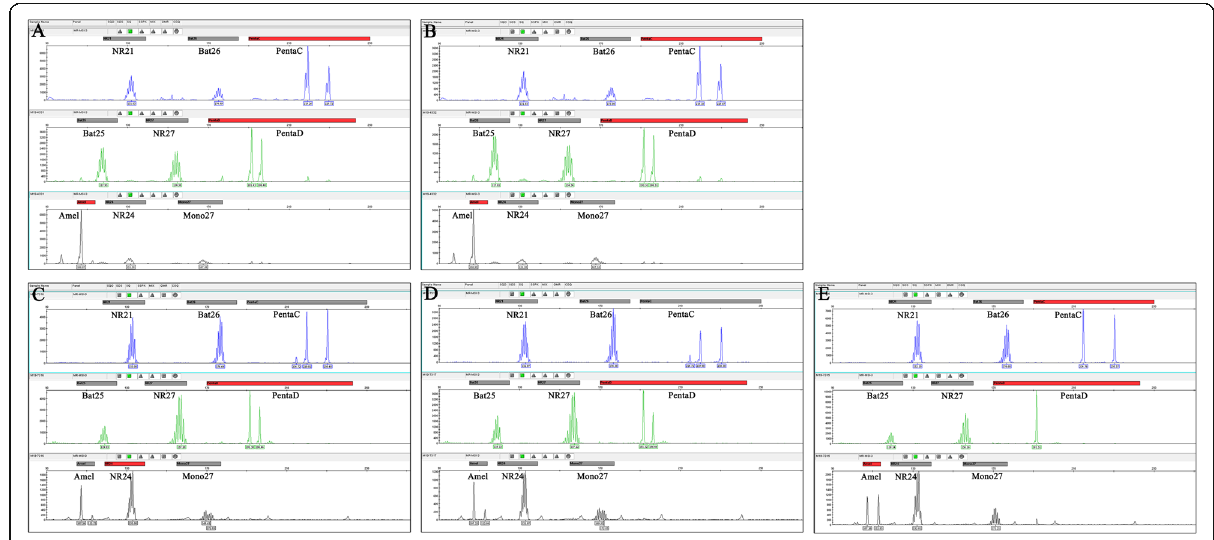
Fig. 4 Length of detection locus as indicated by DNA microsatellite. Recipient 2: A : allograft tissue; B : tumor tissue. Recipient 3: C : allograft tissue; D : tumor tissue; E : blood of recipient. Nucleotide microsatellite loci: NR21, NR24, NR27, Bat25, Bat26, Mono27, PentaC, PentaD and